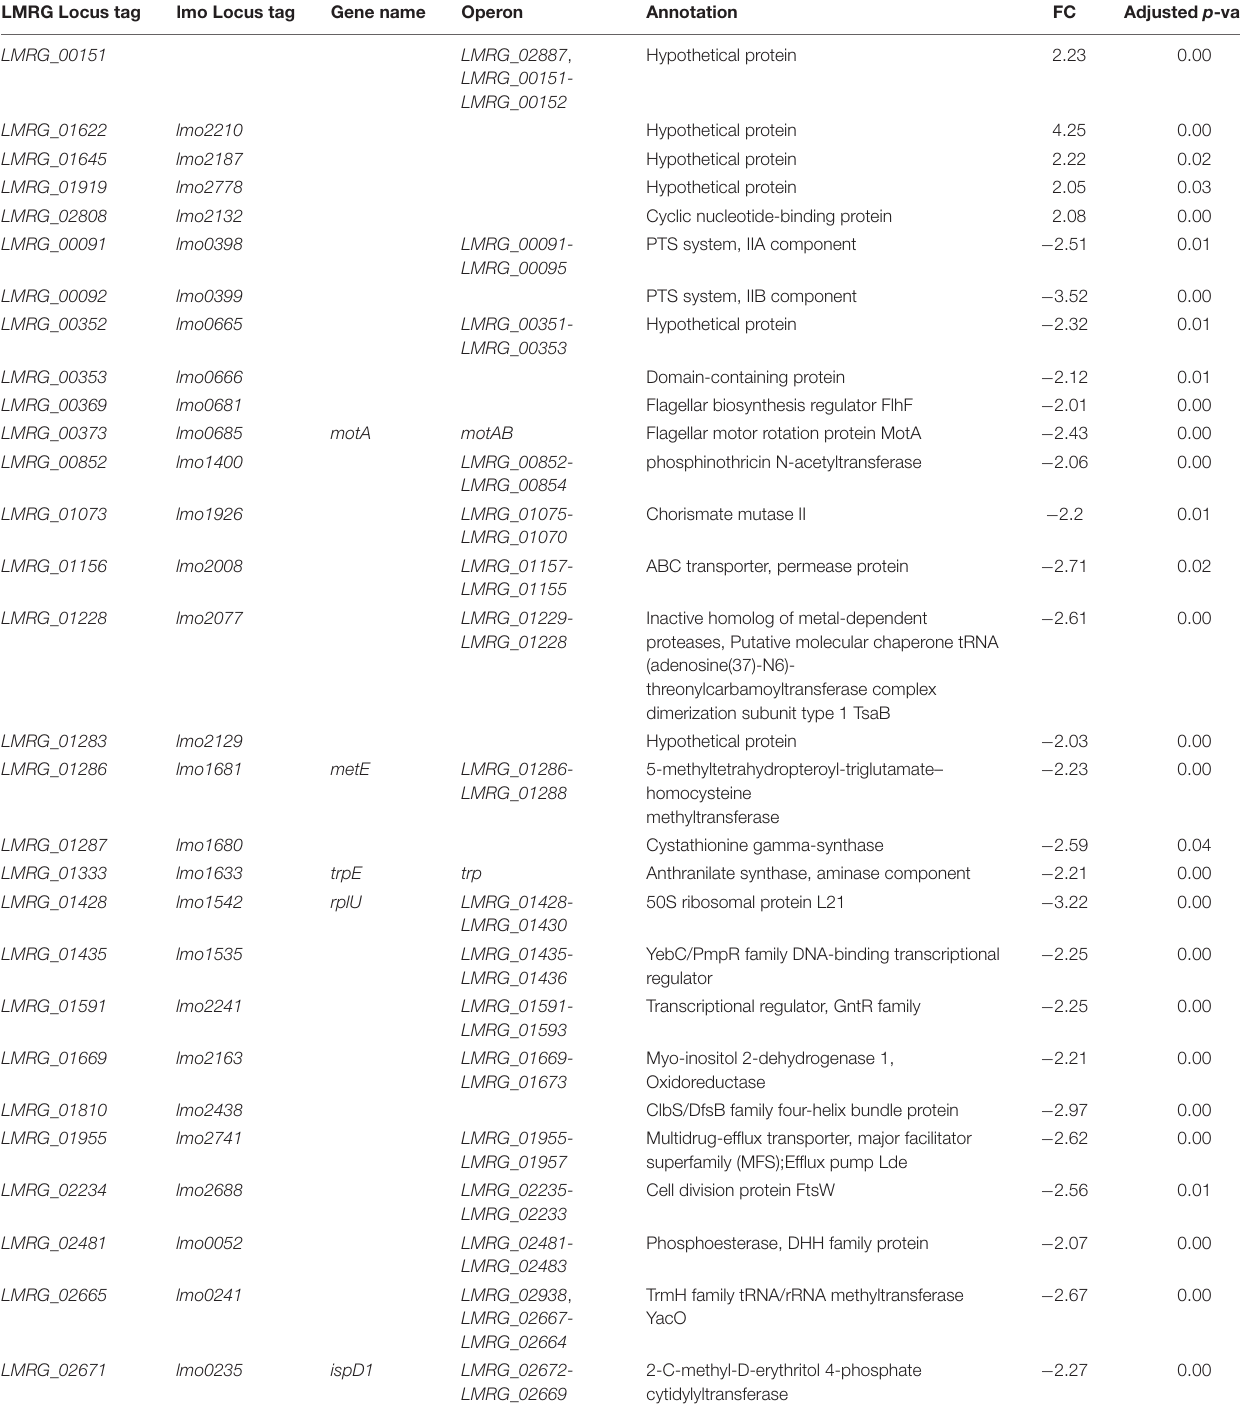
TABLE 3 | Differentially expressed genes under bile exposure in L. monocytogenes (cid:49) sigBCHL quadruple mutant. LMRG Locus tag lmo Locus